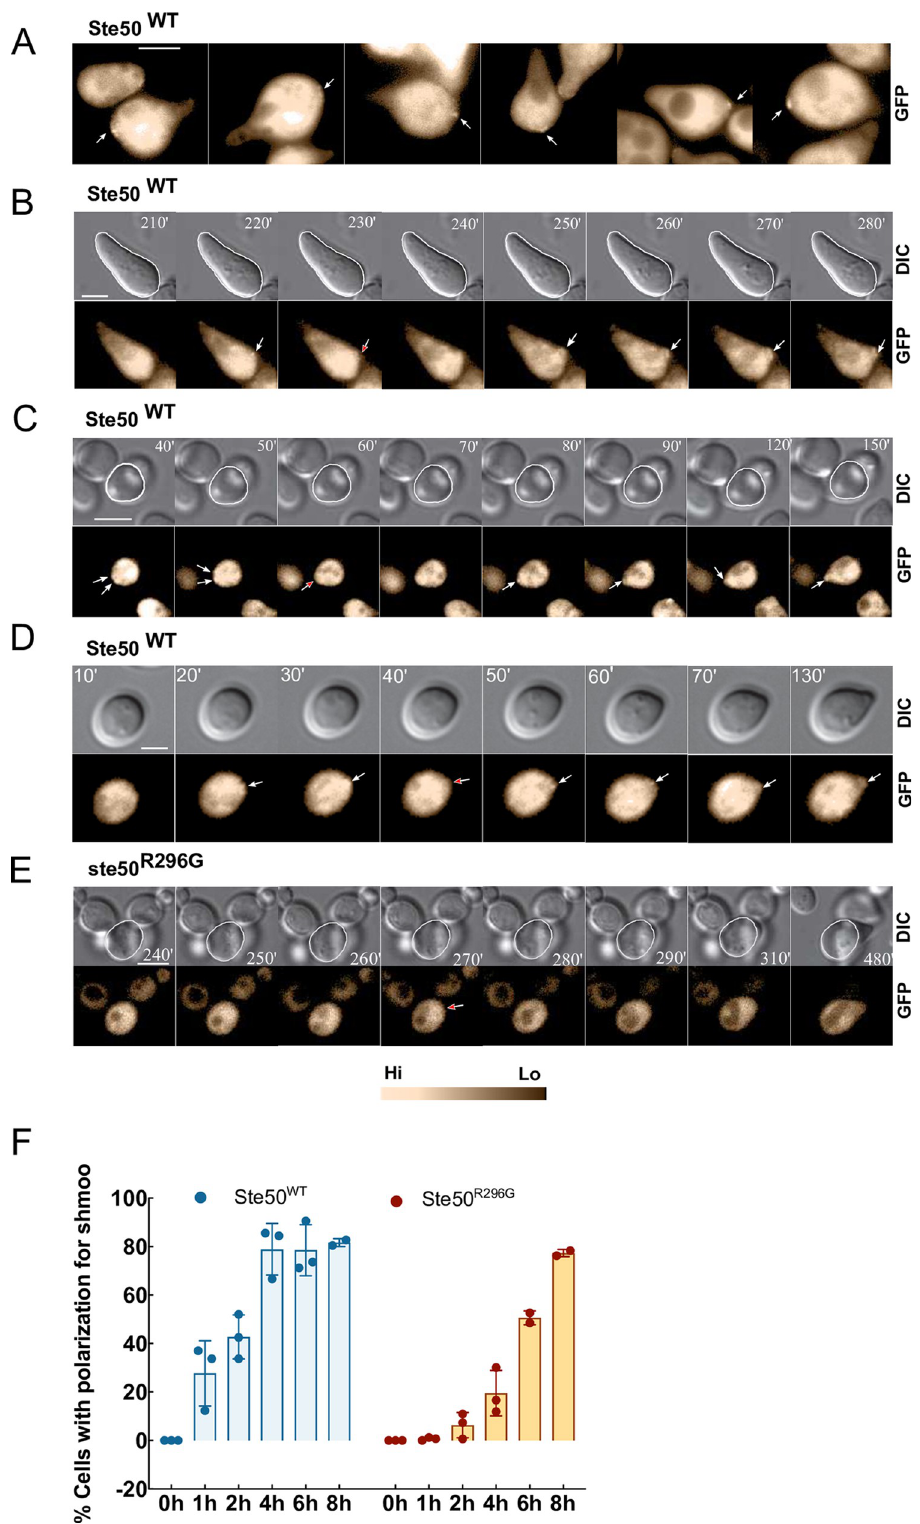
Fig 2. Cortical Ste50p patches are incipient sites for polarization. (A) Ste50-GFP plasmid bearing yeast cells were treated with α -factor and imaged using epifluorescence and DIC still microscopy, showing cortical Ste50p foci